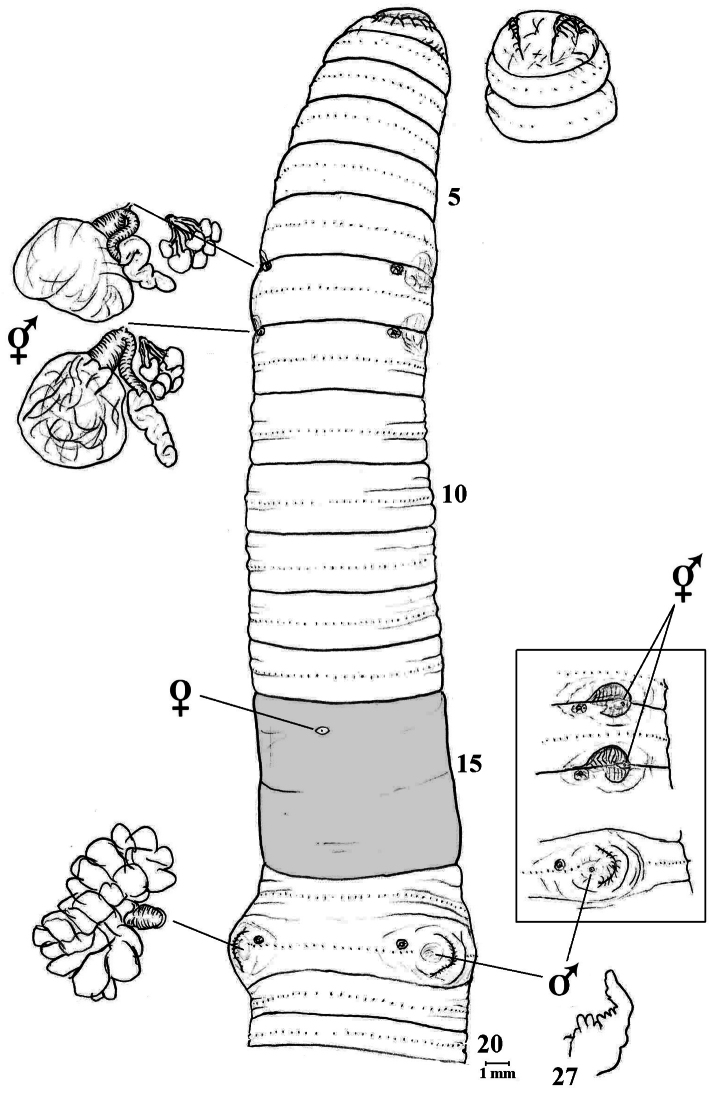
Amynthas daeari sp. n. showing ventral view with spermathecae, their composite genital marking glands and 18lhs prostate in situ plus incised intestinal caecum in 27; dorsal view of prostomium; [boxed are lateral views of spermathecal pores and male field in 18rhs to same scale].